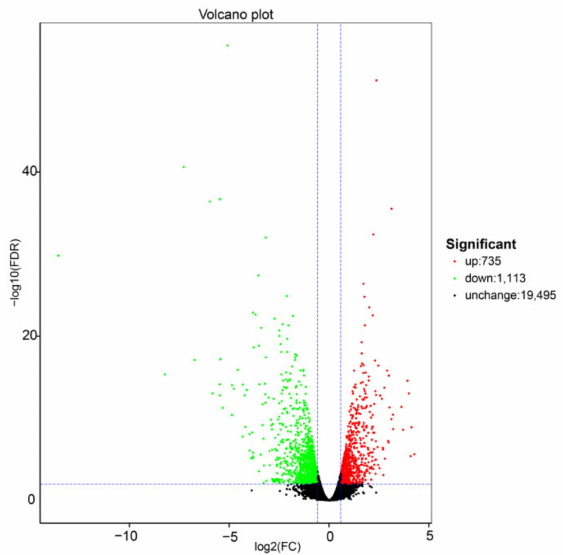
Figure 1. Summary of the number of differentially expressed genes (DEGs) identified by RNA- sequencing analysis and differential expression of Volcano plot of the +S and − S treatments. Each point in the differential expression volcano map represents a gene, and the abscissa represents the logarithm of the differential expression of the gene in the samples. The ordinate represents the negative logarithm of the statistically significant changes in gene expression. The green and red dots represent downregulated and upregulated genes, respectively.